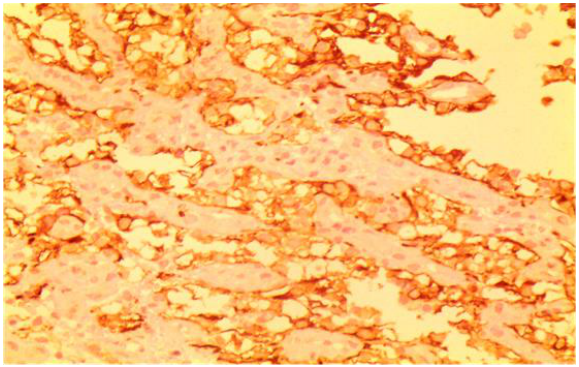
Fig 5 . IHC; pan ck, vimentin and CD10 had positive results but CK7 and CD68 were